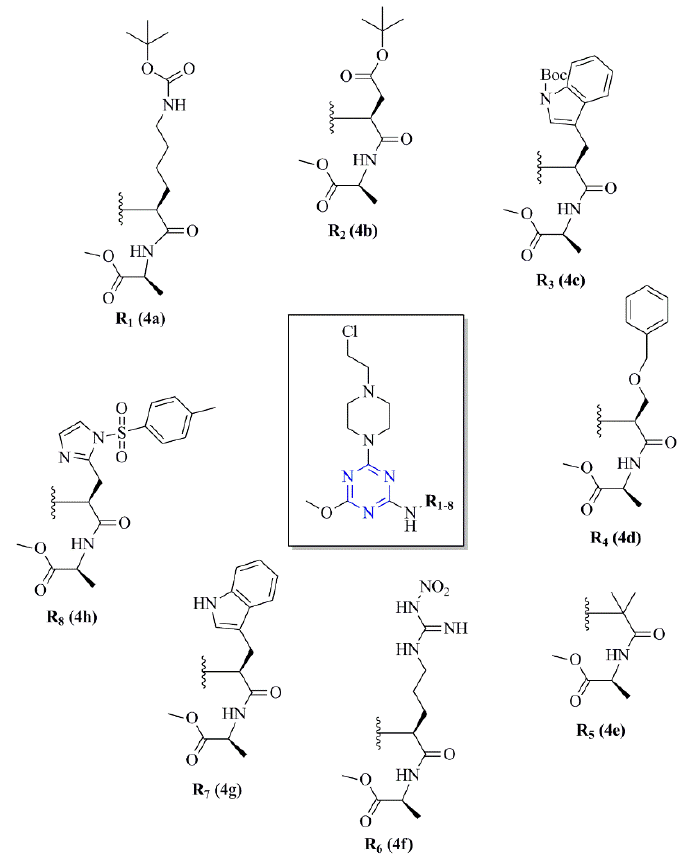
Figure 2. Structures of the new triazine-peptide-mustards ( 4a – 4h ).